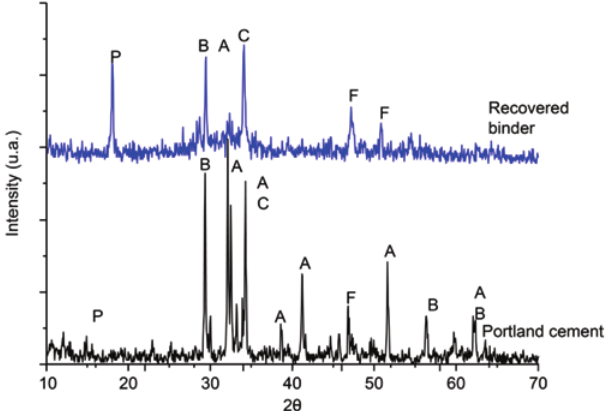
Figure 3 Diffractograms of Portland cement and recovered binder (paste thermally treated at 550 °C). Peaks: calcium hydroxide (P), tricalcium silicate (A), dicalcium silicate (B), calcium carbonate (C), calcium ferroaluminate